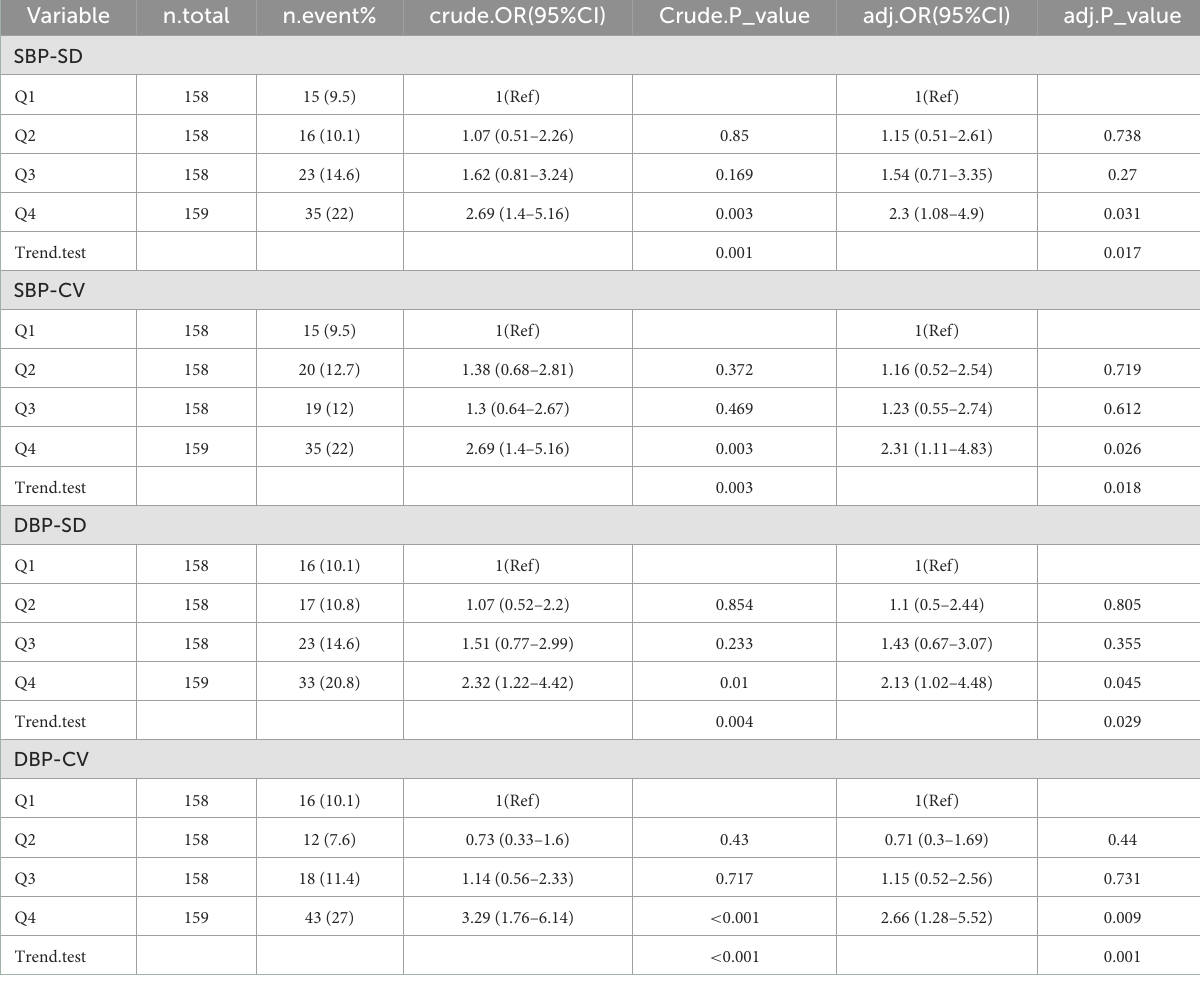
TABLE 3 Odds ratios for adverse outcomes according to quartiles of BP variability.